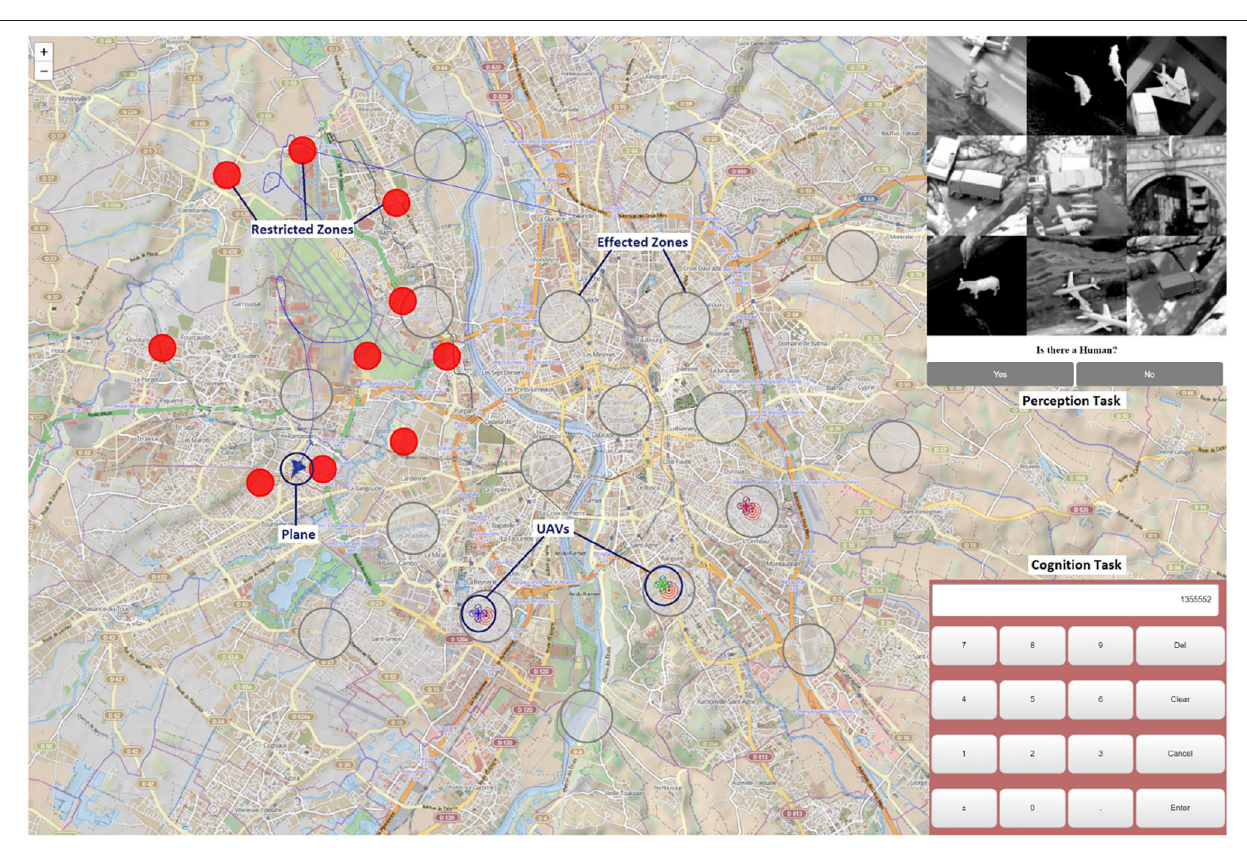
FIGURE 3 | Zoom on the UAV application U-track used by the flying pilot to interact with UAVs. different in: (i) the number of communication channel inputs (i.e., 1 vs. 2 randomly selected UAVs) and their value (i.e., the heading value plus 100 for one UAV communication channel